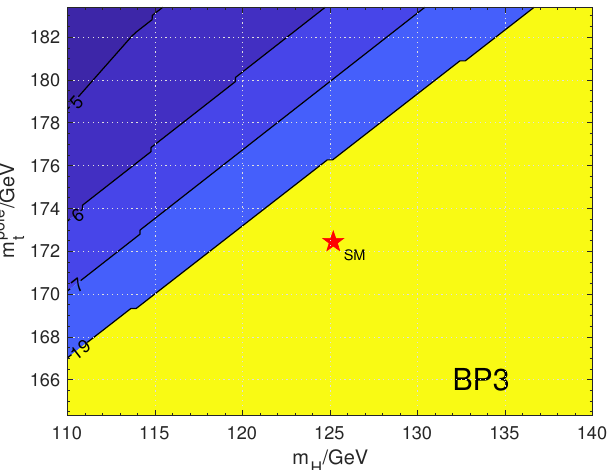
) plane with benchmark points BP1 – BP3 . The Figure 6. Vacuum stability of SMASH in ( m H , m pole t red star corresponds to the SM best-fit value. The height and width of the star correspond to the present uncertainties. The vacuum is stable in the yellow region. The contour numbers n correspond to the vacuum instability scale 10 n GeV.